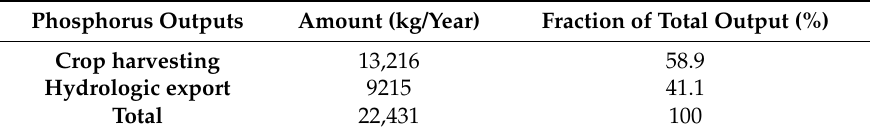
Table 7. Summary of phosphorus outputs in the Haean